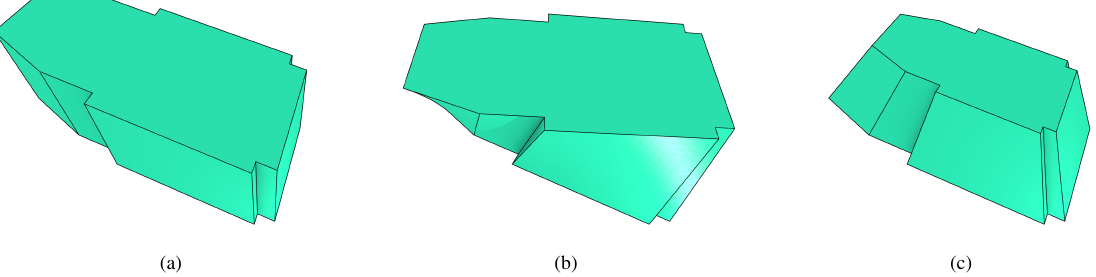
Figure 4: Applying various transformations to a building footprint along the LOD axis: (a) translation, (b) rotation and (c) scale.